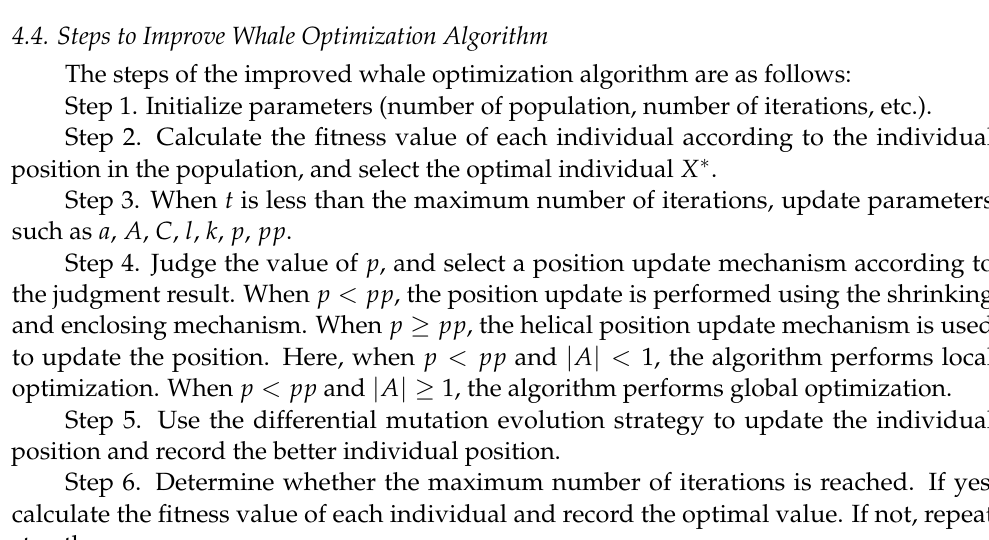
Figure 6 is a flowchart of the improved whale optimization algorithm.